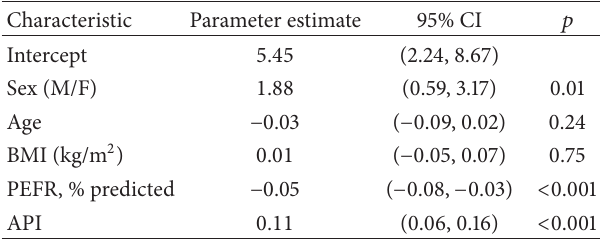
Table2:Multiplelinearregressionmodeltopredictcorrelationwith the Borg scale score.